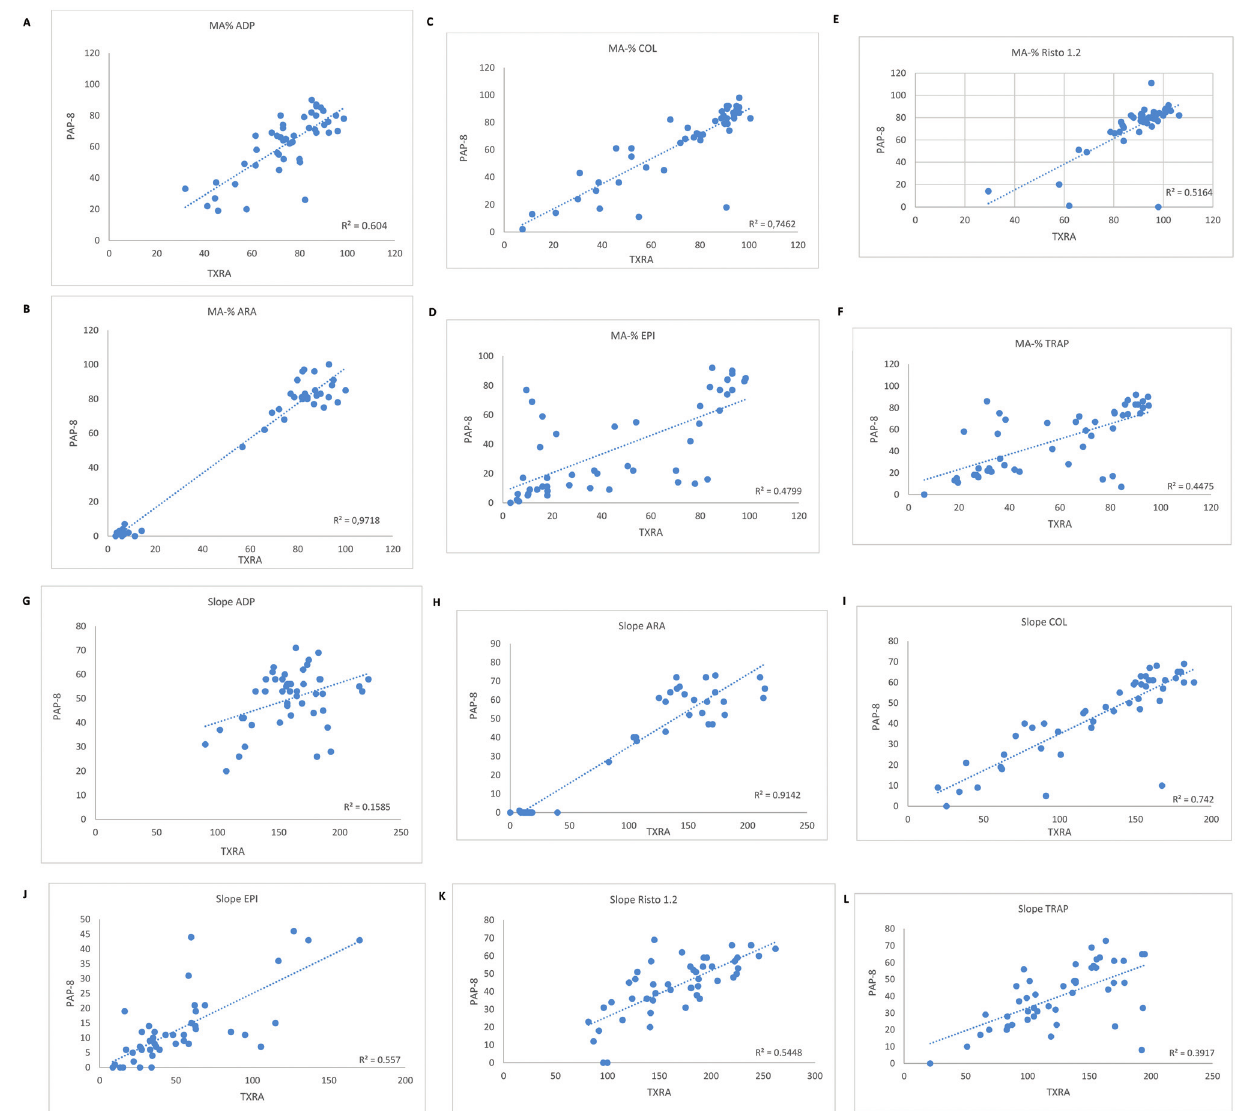
Fig. 3 Method comparison of individual reagents betweenTXRA and PAP-8 in 47 patients: MA% and slope values. ( A – F ) maximum aggregation valuesinpercentage, and ( G – L ) slope values (in instrument speci fi c dimensions). Y -axis shows PAP-8, andX-axis showsTXRA results. R 2 , Pearson ’ s correlation coef fi cient. Results obtained with RISTO 0.6 are not shown graphically because of the weak signal generated.